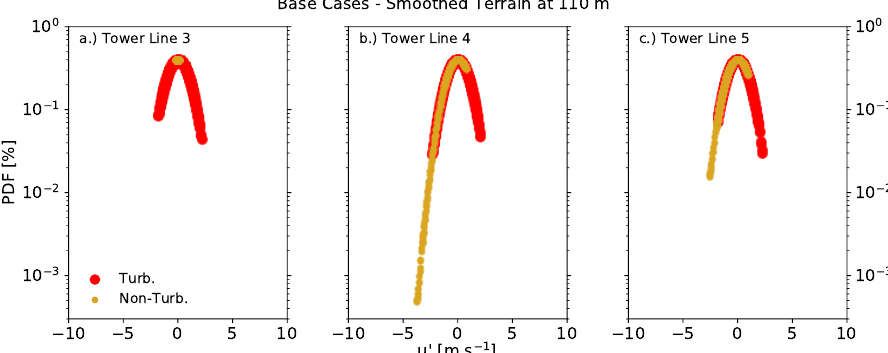
Figure 12. PDFs of the perturbation to the u -component wind speed for the turbulent inflow (red) and non-turbulent inflow (yellow) cases at Tower Lines 3, 4, and 5 in the ( a – c ) panels, respectively. Spectral analysis of the tower lines in the smoothed terrain cases show what one would expect from these flow fields (Figure 13). Near the inflow (Tower Line 1; a), the non- turbulent inflow is largely energy-deficient across all frequencies. As the flow progresses, the perturbed inflow cases come close to matching the turbulent inflow rather quickly at this level. Meanwhile, the non-turbulent inflow case never fully develops and the energy deficiency remains significant across all